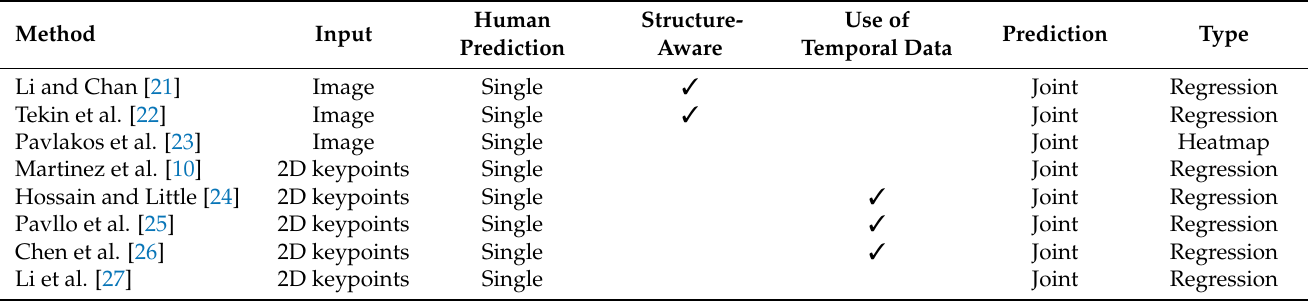
Table 2. Comparison of the key differences between methods for 3D pose estimation. A checkmark in column Structure-aware represents the methods’ ability to ensure the validity of the human skeleton structure. A checkmark in the column Use of temporal data represents whether the method uses previous predictions or other temporal information. Image in column Input means that the model predicts directly from the image, while 2D keypoints means that the model “lifts” the 2D keypoint to the 3D